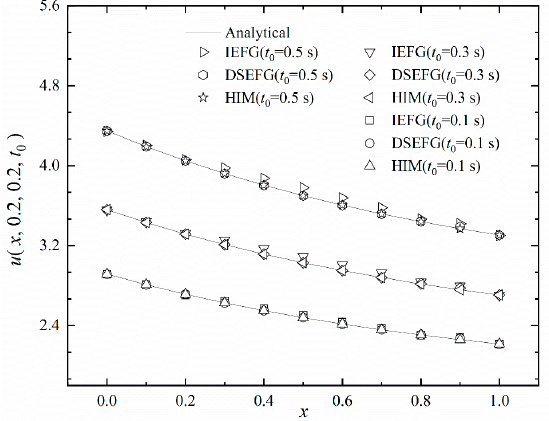
Figure 1. Calculation results along x -axis when t 0 is different.